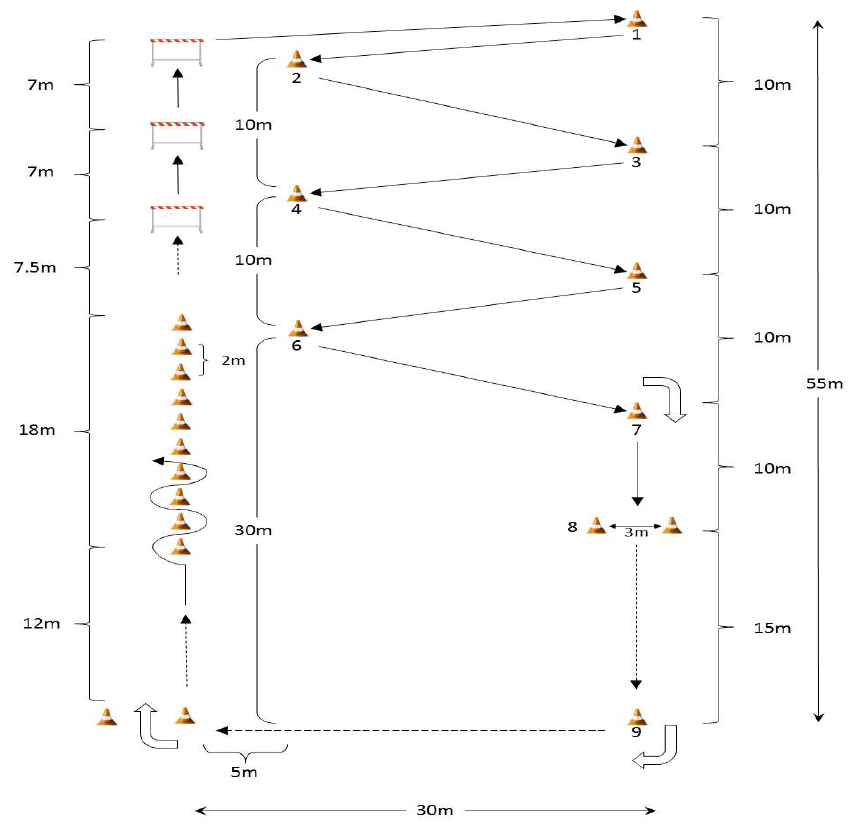
Figure 2. Illustration of the Hoff circuit exercise. The participants dribble the ball through the cir- cuit. The circuit length is set of 51.5 m on left-hand side and 55 m on the right-hand side and the width is set of 35 m. The participants were required to perform backward dribbling between the cone 7 to the gate 8. Three hurdles (30–35 cm height) and 22 cones (two for the starting line and two cones for the backward run gate) were set on the field. Total distance of per lap is 290 m. The distance between hurdle 3 and cone 1 is 30.5 m. The distance between cones (1–2, 2–3, 3–4, 4–5, 5–6 and 6–7) is 25.5 m each [27].